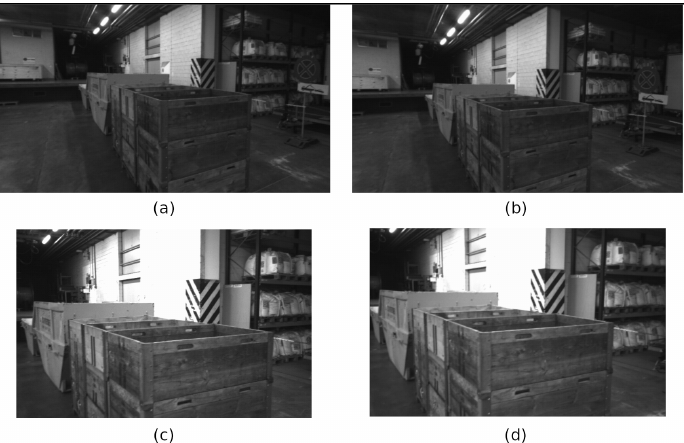
Figure 1. A sample set of images taken by a four camera rig (two stereo cameras placed side by side) used in ETH3D Benchmark, ( a ) the left image from the left stereo camera, ( b ) the right image from the left stereo camera, ( c ) the left image from the right stereo camera, ( d ) the right image from the right stereo